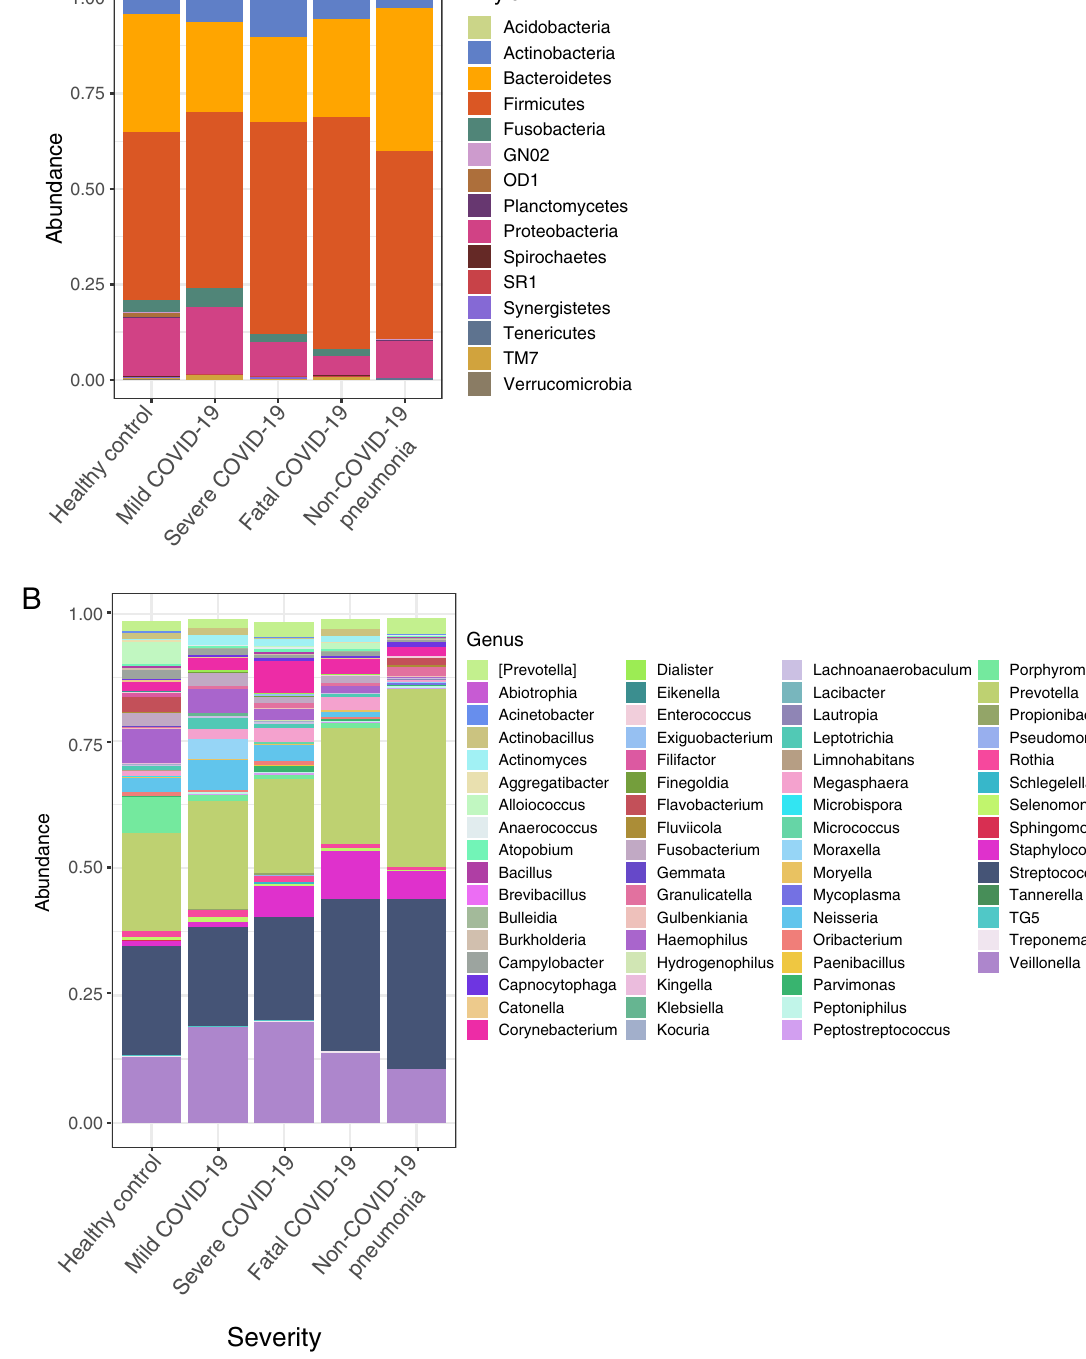
Figure 1. Microbial composition at phylum and genus level between patients with different severity levels of COVID-19 and controls. ( A ) Stacked barplot summarizing microbial composition between groups at phylum level. ( B ) Stacked barplot summarizing microbial composition between groups at genus level. Each color represents a taxa described in Phylum and Genus